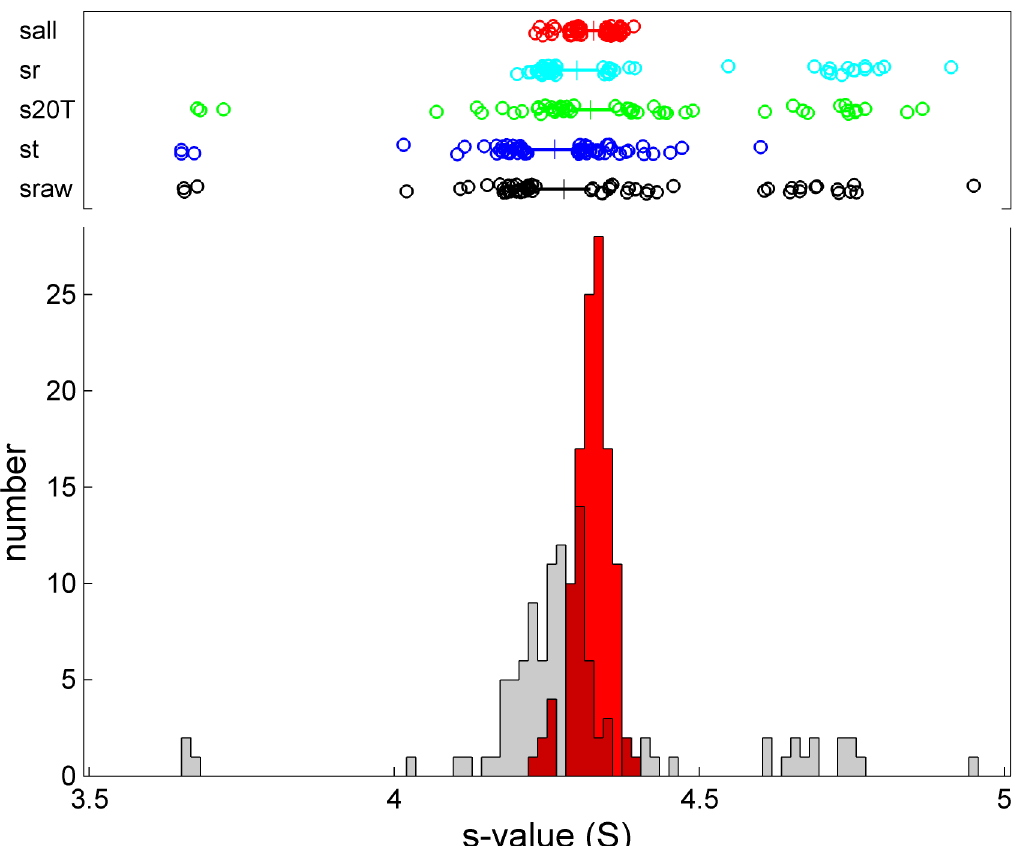
Fig 9. Histogram and box-and-whisker plot of s -values of the BSA monomer after different corrections: Raw experimental s -values (black, with grey histogram), scan time corrected s t -values (blue), rotor temperature corrected s 20T -values (green), or radial magnification corrected s r -values (cyan), and fully corrected s 20T , t , r , v -values (red with red histogram). The box-and-whisker plots indicate the central 50% of the data as solid line and draw the smaller and larger 25% percentiles as individual circles. The median for each group is displayed as a vertical line.